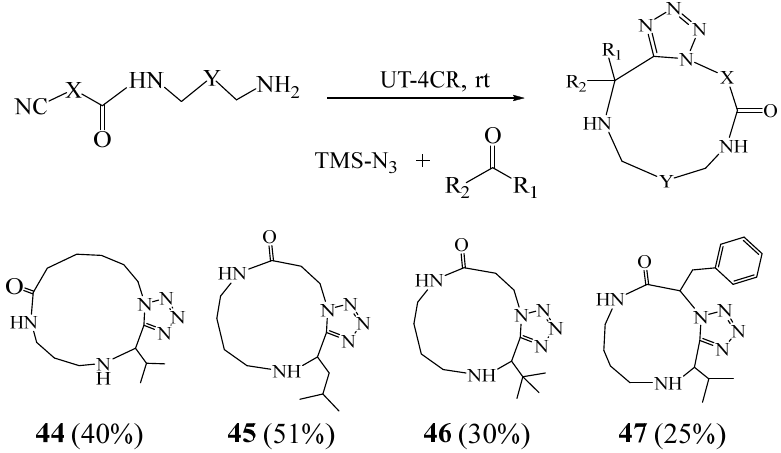
Figure 14. Monetetrazole containing macrocycles 44 − 47.